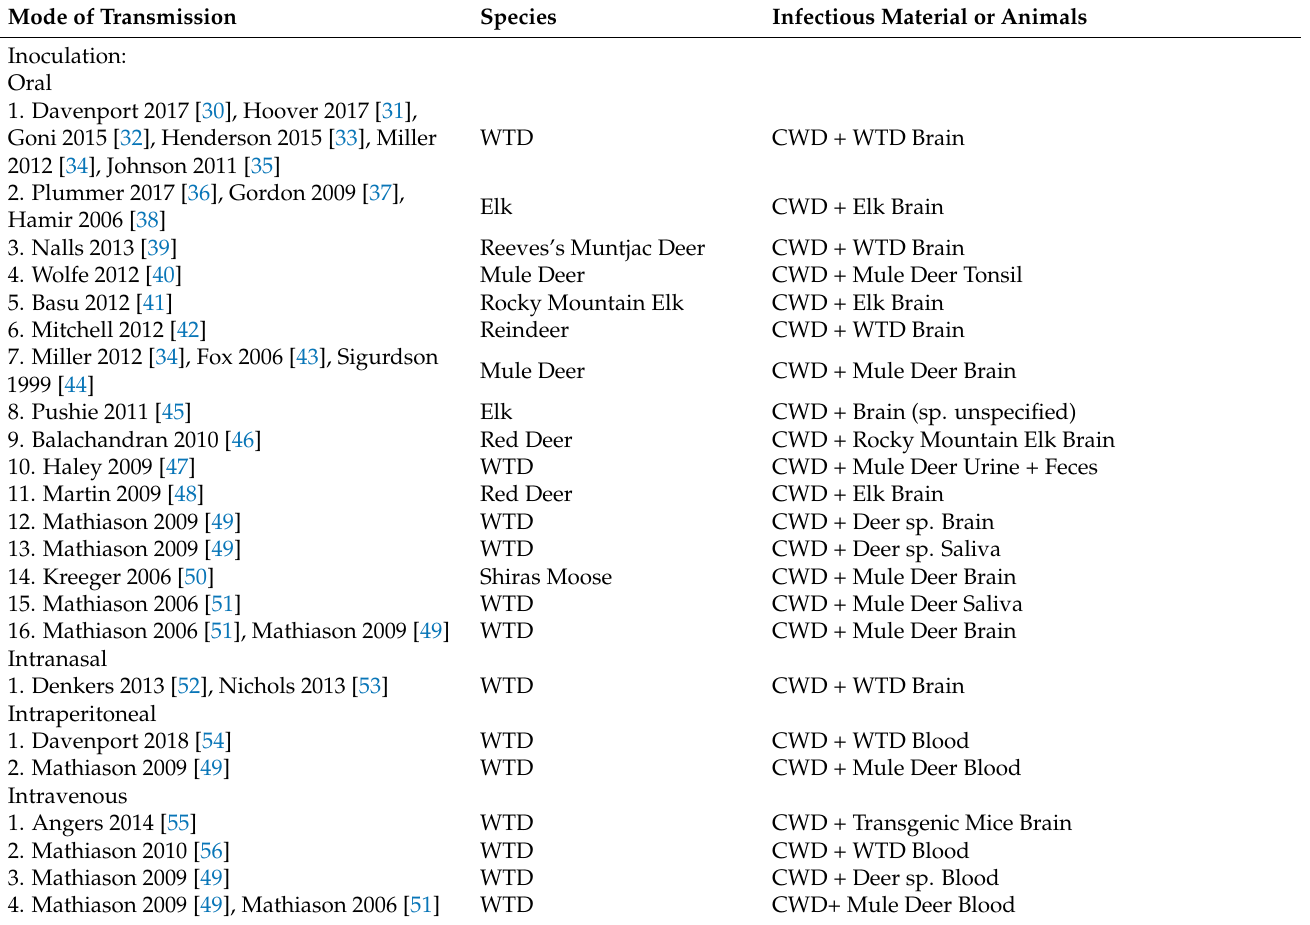
Table 1. Studies demonstrating CWD transmission in controlled settings. Mode of Transmission Species Infectious Material or Animals